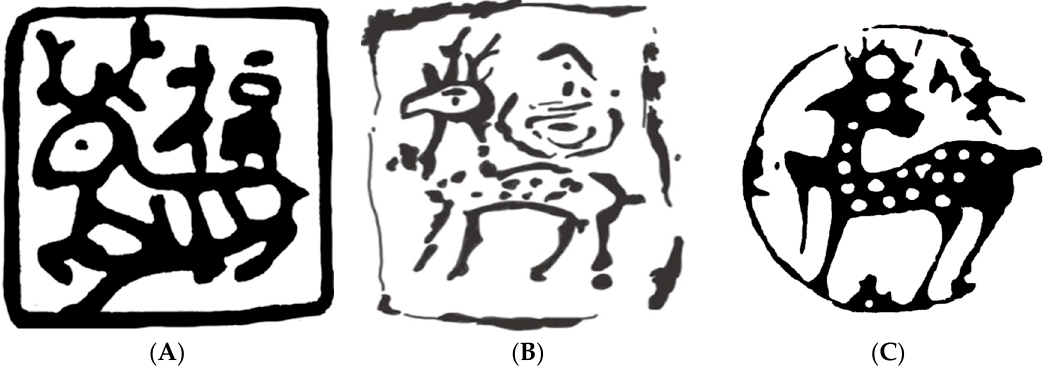
Figure 2. ( A ) A Song Yuan Huaya with a deer motif. The period of the Song and Yuan dynasties. Inventory number: 0670. Sketched by author. Picture source: Wen (1995), p. 195. ( B ) A Song Yuan